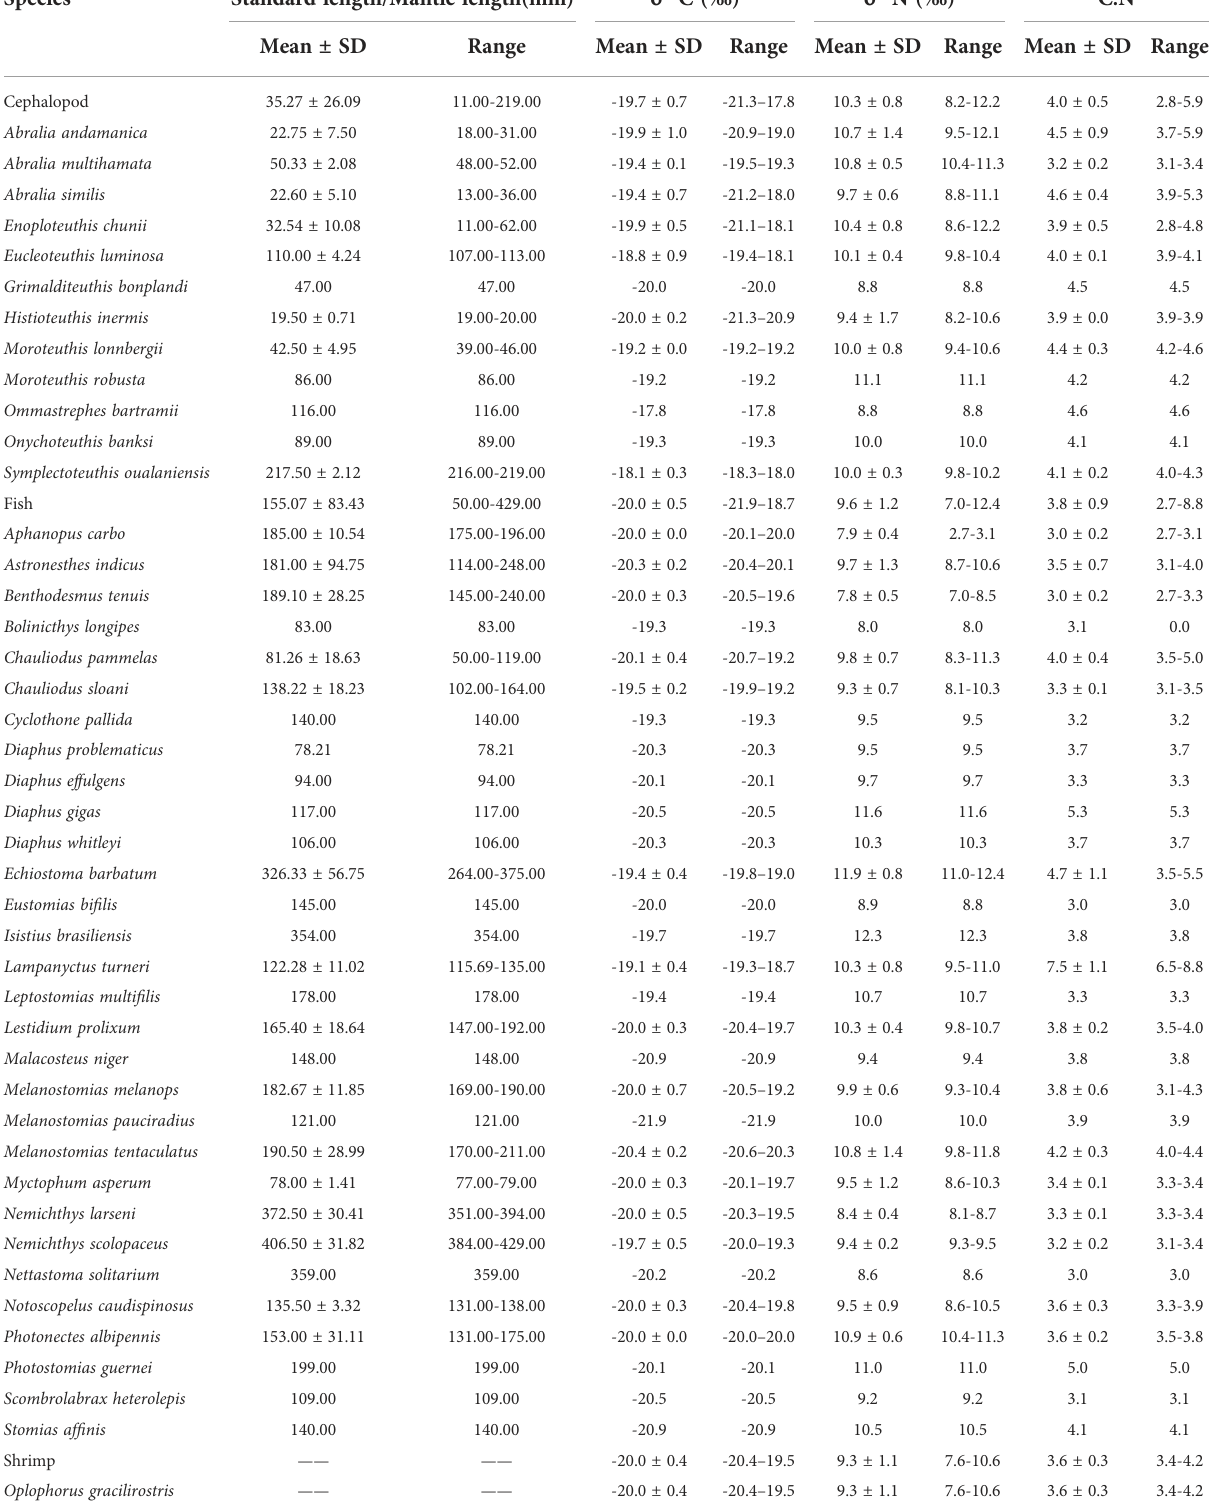
TABLE 5 Biological information of micronekton and d 13 C and d 15 N values of muscle tissue.